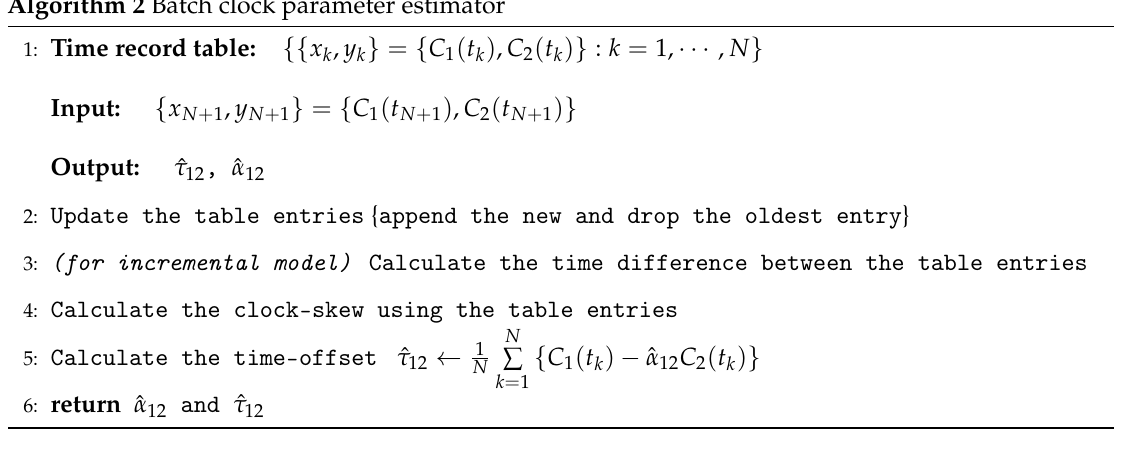
Algorithm 2 Batch clock parameter